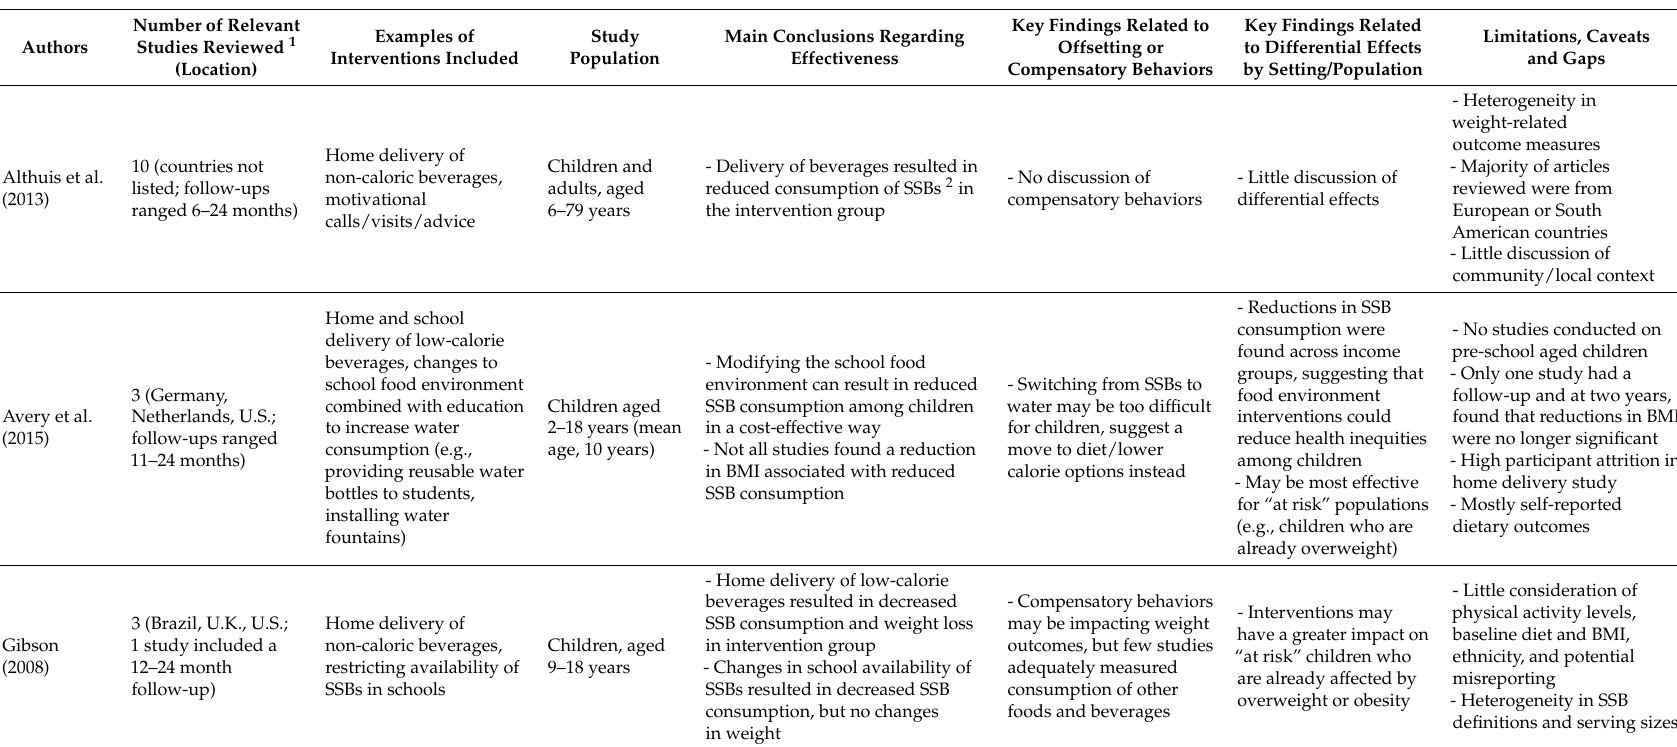
Table 3. Overview of evidence on interventions influencing changes to the food environment ( n = 7